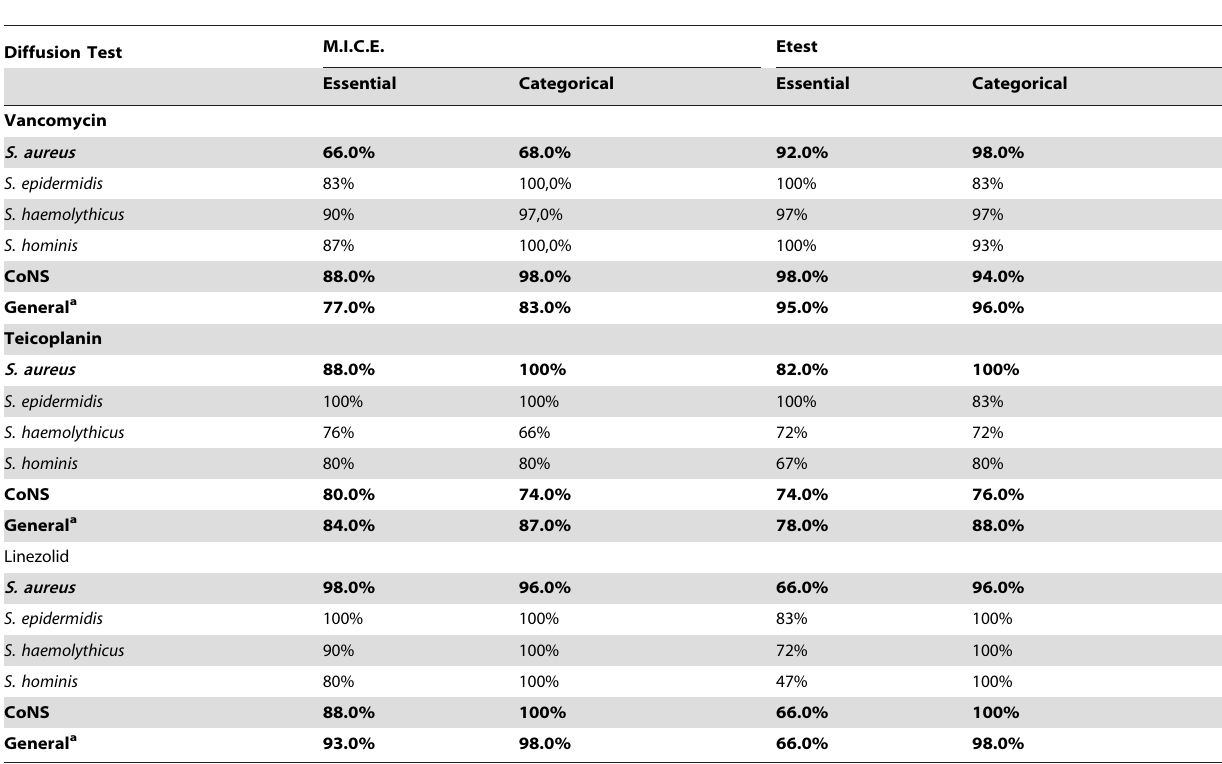
Table 1. Essential and categorical agreement rates between gradient diffusion tests (M.I.C.E. and Etest) against Staphylococcus